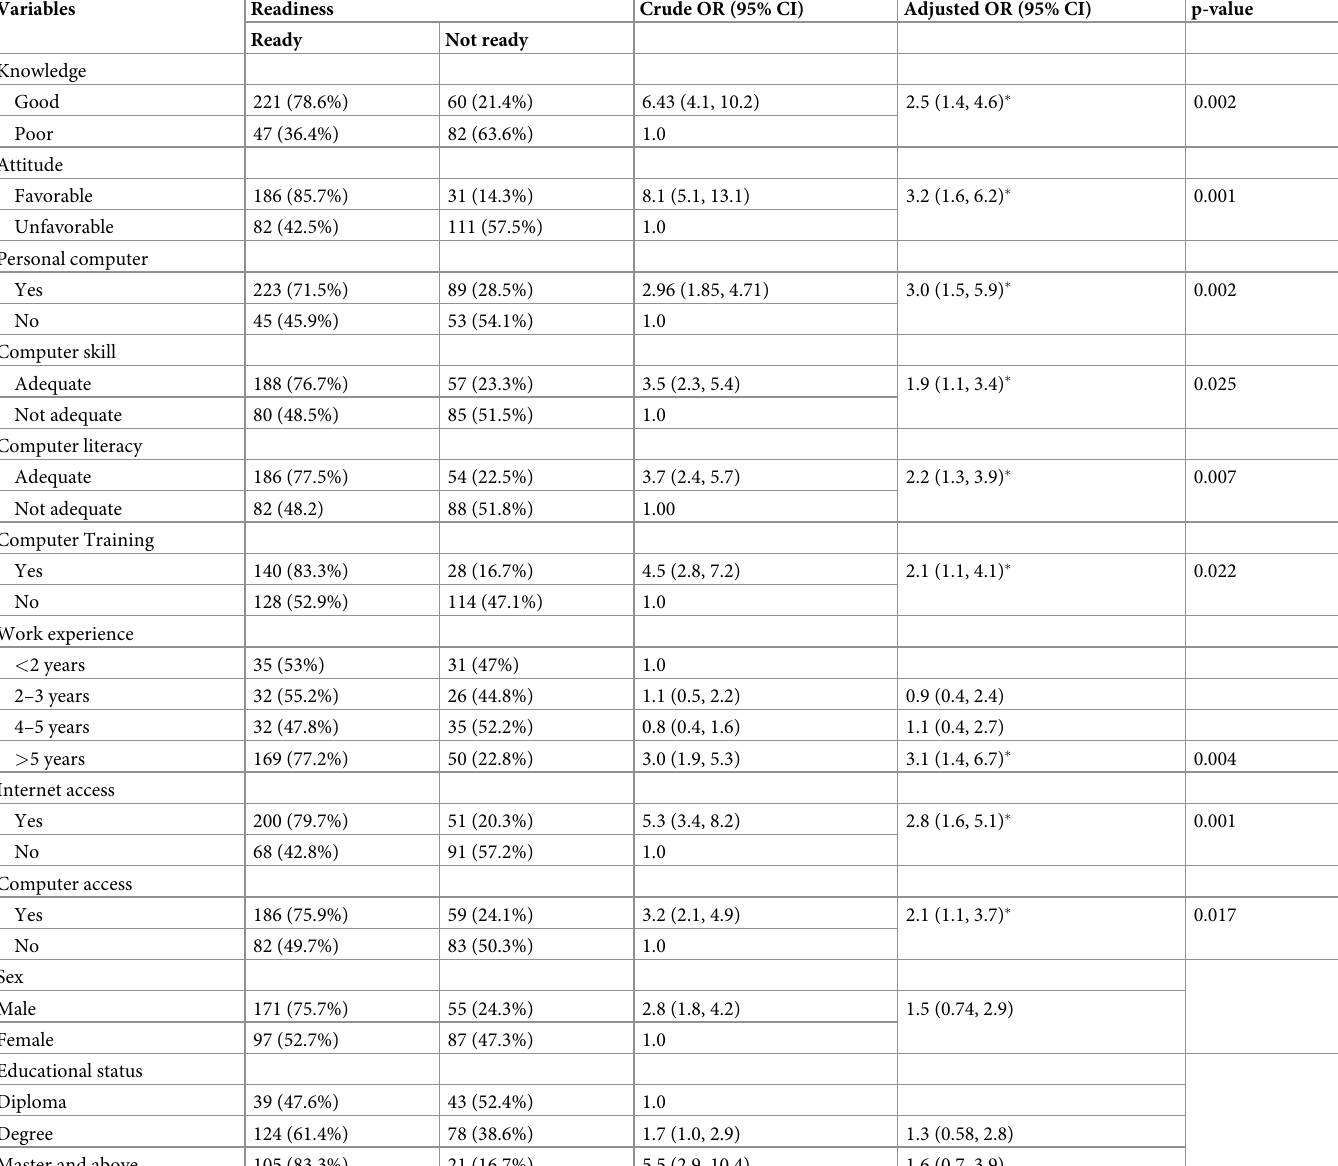
Table 4. Bi-variate and multivariate analysis on factors associated with readiness of health professionals for telemedicine system in private hospitals, Amhara region, 2021.